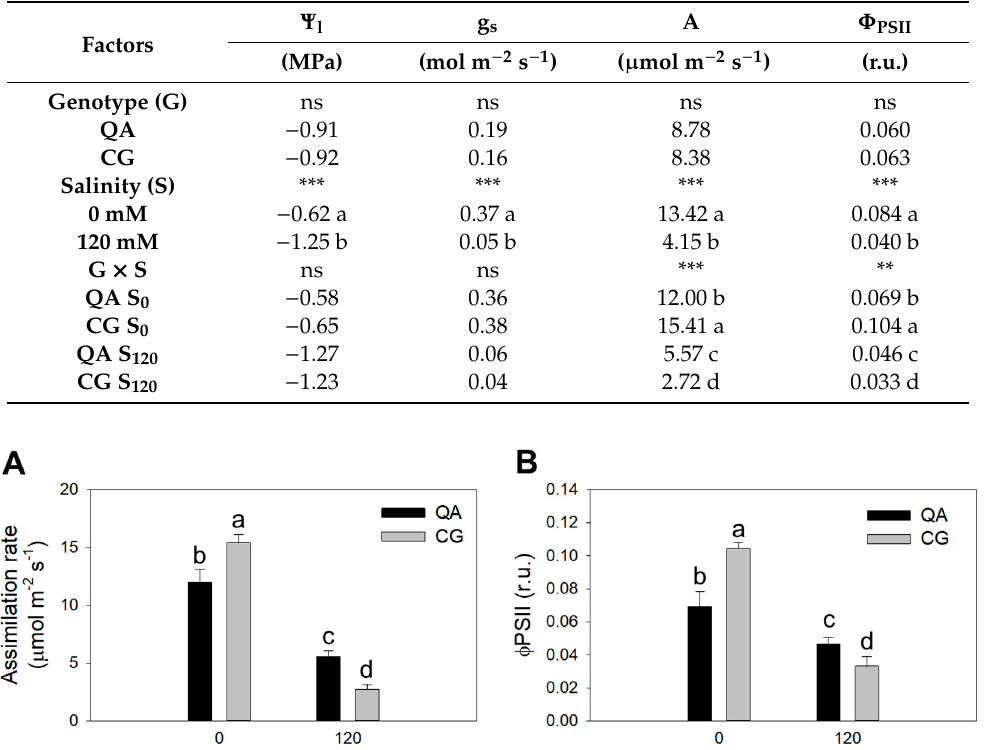
Table 2. Effect of genotype, salinity and interaction on leaf water potential ( Ψ l ), stomatal conductance (gs), net photosynthetic CO 2 assimilation (A, µmol m 2 s − 1 ) and Φ PSII at DAT 102 of the commercial cultivar (QA) and the landrace (CG) grown at control (0 mM) and high salinity (120 mM). ns, *, **, *** indicate not significant or significant differences at p < 0.05, p < 0.01 and p < 0.001, respectively. In each column, for each factor, means with the same letter are not significantly